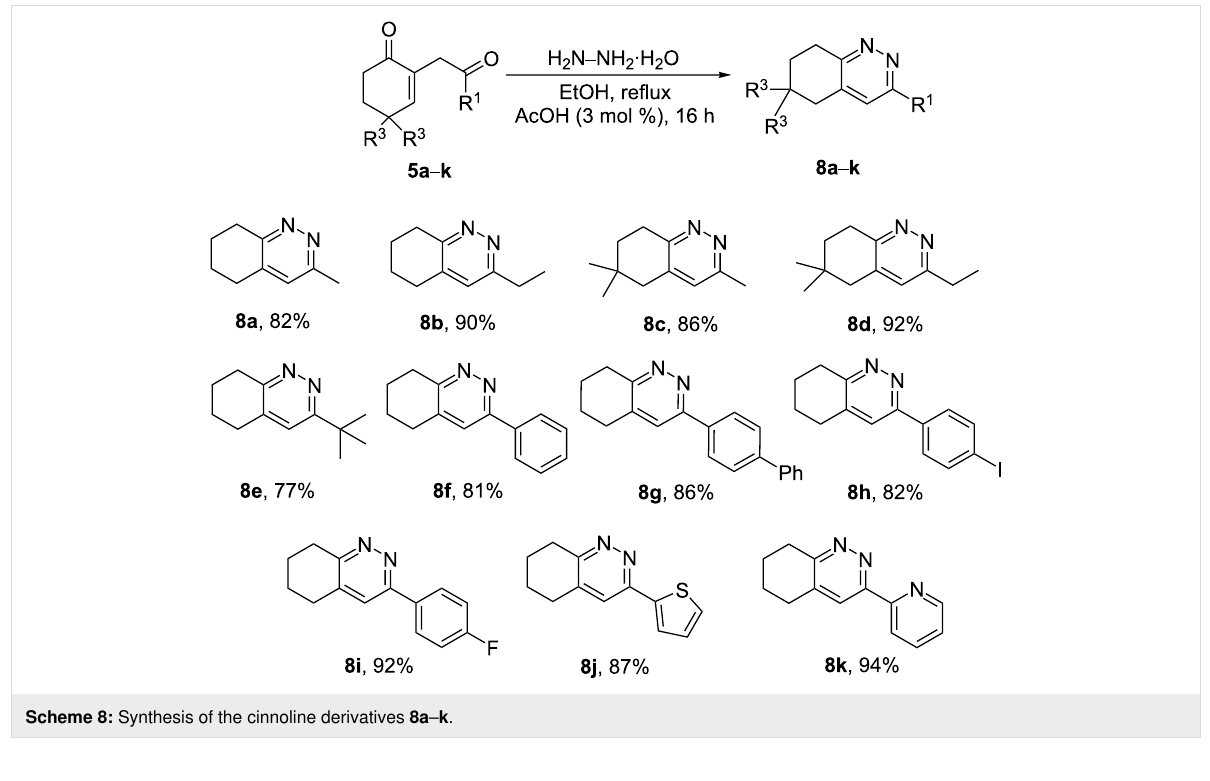
Scheme 8: Synthesis of the cinnoline derivatives 8a – k .